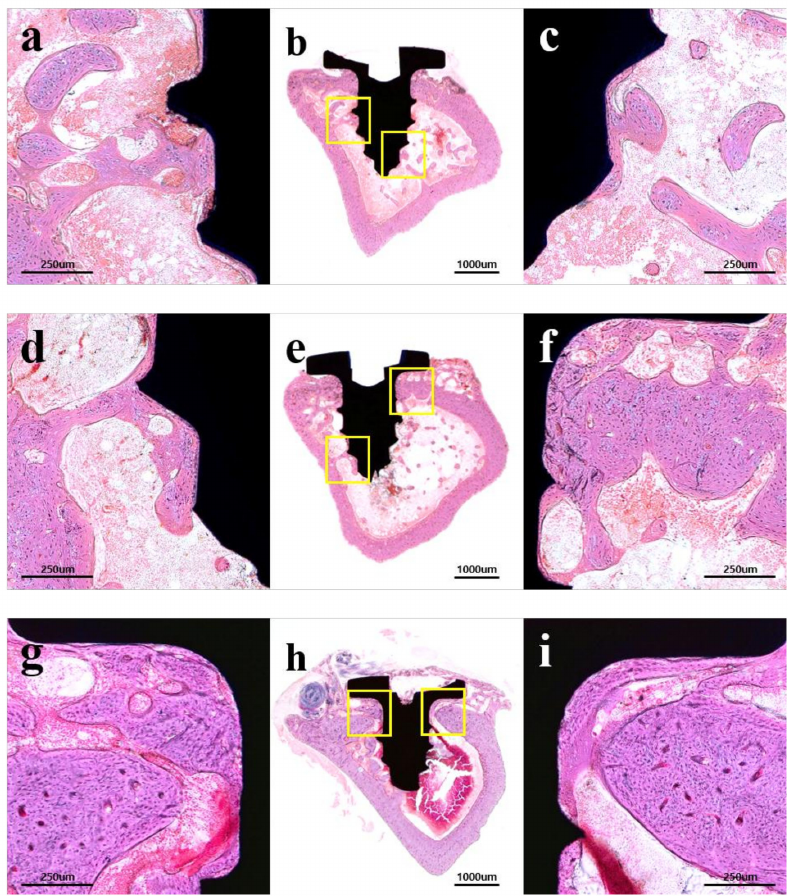
Figure 7. Hematoxylin-eosin (H&E) stained histological sections: ( a – c ) control; ( d – f ) GA group; ( g – i ) 25 kGy group; ( a , d , g ) left portion of implant; ( c , f , i ) right portion of implant; ( a , c , d , f , g , i ) × 100 magnification; and ( b , e , h ) × 12.5 magnification.